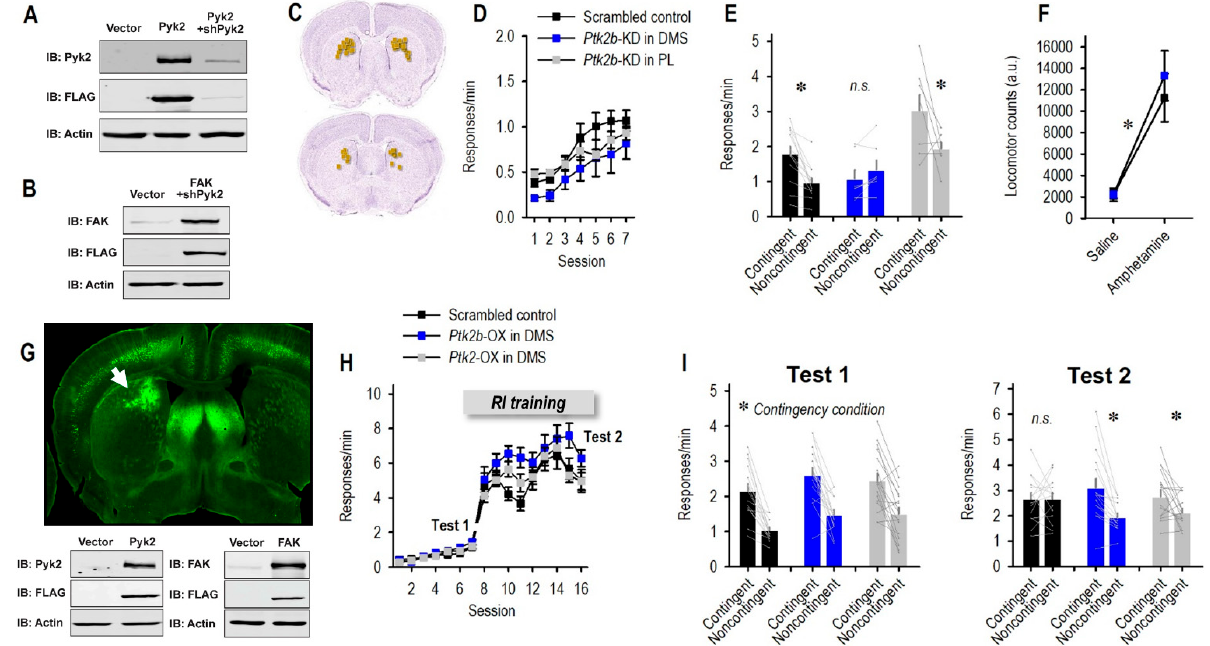
Figure 3. Striatal Pyk2 is necessary for sustained behavioral flexibility. ( A ) Immunoblot analysis of Ptk2b knockdown in HEK293T cells. Cells were transfected with a control lentiviral vector, Pyk2-FLAG expressing lentiviral vector, or Pyk2-FLAG expressing vector, together with Pyk2 shRNA lentiviral vector, to determine Pyk2 knockdown efficiency. ( B ) Cells were transfected with a control vector or with a FAK-FLAG expressing vector, together with Pyk2 shRNA, to determine the knockdown specificity of Pyk2 shRNA. As illustrated, the Pyk2 shRNA sequence is specific to Pyk2 and does not deplete the closely related FAK. ( C ) Composite of viral vector infusion sites in the DMS in this report. Each square represents an individual infusion. ( D ) Mice acquired nose poke responses on 2 ports; responses on both ports are collapsed for simplicity. ( E ) When the association between one response and its outcome was violated via noncontingent pellet delivery, control mice and mice with Pyk2 silenced in the prefrontal cortex (PL subregion) inhibited the response. Meanwhile, silencing Pyk2 in the DMS obstructed response plasticity ( n = 13 combined control group, n = 7 DMS, n = 7 PL). ( F ) Mice with Ptk2b knockdown in the DMS displayed typical locomotor activity, including when treated with amphetamine. ( G ) Top : A unilateral viral vector infusion in the DMS is shown in a coronal section from a mouse expressing Thy1 -driven YFP, to visualize anatomical landmarks. Bottom : Immunoblot analysis of Pyk2 and FAK overexpression in HEK293T cells. Cells were transfected with the viral vector control, Pyk2 overexpressing lentivirus, or FAK overexpressing lentivirus. ( H ) Mice were trained to nose poke for food reinforcers, and tests for behavioral flexibility are indicated, as are training sessions using random interval (RI) schedules of reinforcement. ( I ) For the first test, all mice inhibited a behavior when it was unlikely to be reinforced (noncontingent condition). With further training, control mice developed habit-like behavior—indicated by equivalent responses on both apertures, while mice with Pyk2 and FAK overexpression retained behavioral flexibility. Thus, Pyk2 and FAK overexpression improved response flexibility. n = 15 control, n = 16 Pyk2, n = 17 FAK, * p < 0.05. KD, knockdown. NS, non-significant. OX, over-expression. PL, prelimbic. Error bars represent SEM. Line connecting bars represent individual mice.